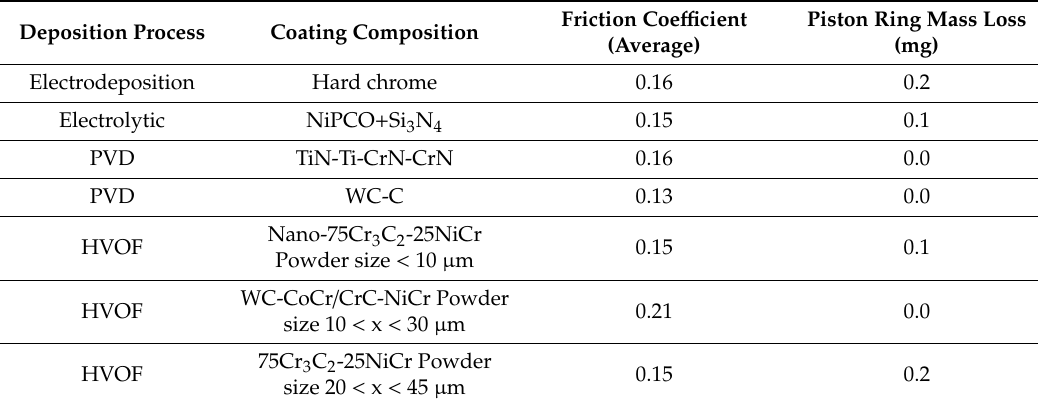
Table 8. Ring-cylinder liner friction and wear results with di ff erent